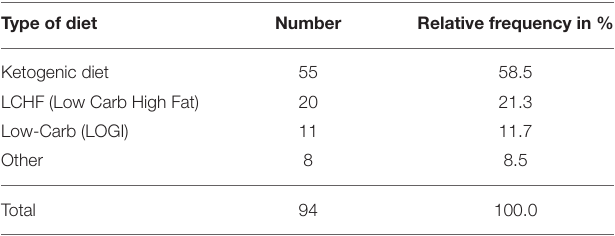
TABLE 2 | Dietary protocols followed by the study participants at the time of cancer diagnosis or therapy. Type of diet